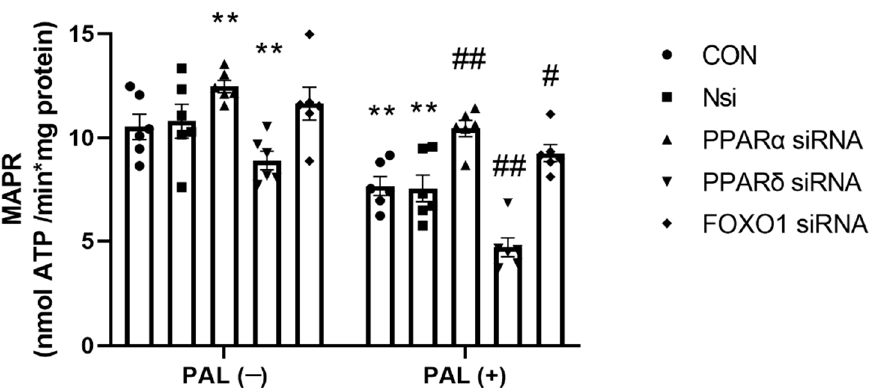
Figure 4. Maximal mitochondrial ATP production rates (MAPR) from pyruvate + malate in C2C12 myotube after individual PPAR α , PPAR δ and FOXO1 siRNA gene silencing in the absence ( left panels ) or the presence of palmitate (PAL; right panels ). Significantly different from control without PAL (CON, ** p < 0.01). Significantly different from CON + PAL ( # p < 0.05; ## p < 0.01). Data represent mean ± SEM of 6 individual experiments for each intervention group. Nsi—silencer negative con- trol.